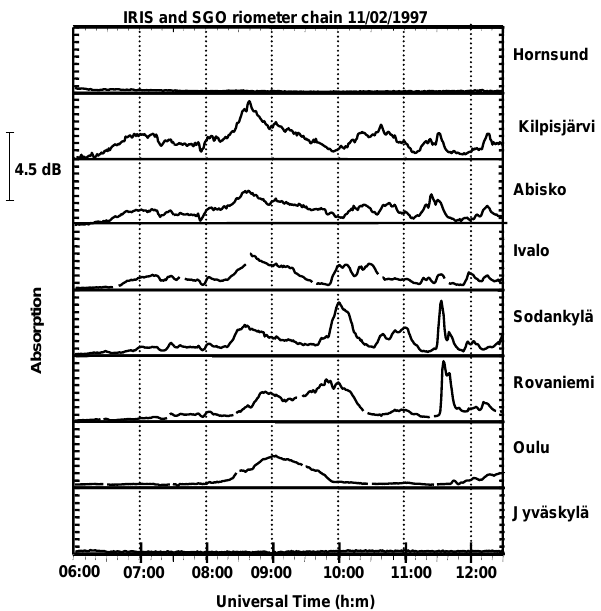
Fig. 5. A stack plot of riometer data comprised of IRIS and the SGO chain. The instruments are ordered by descending magnetic